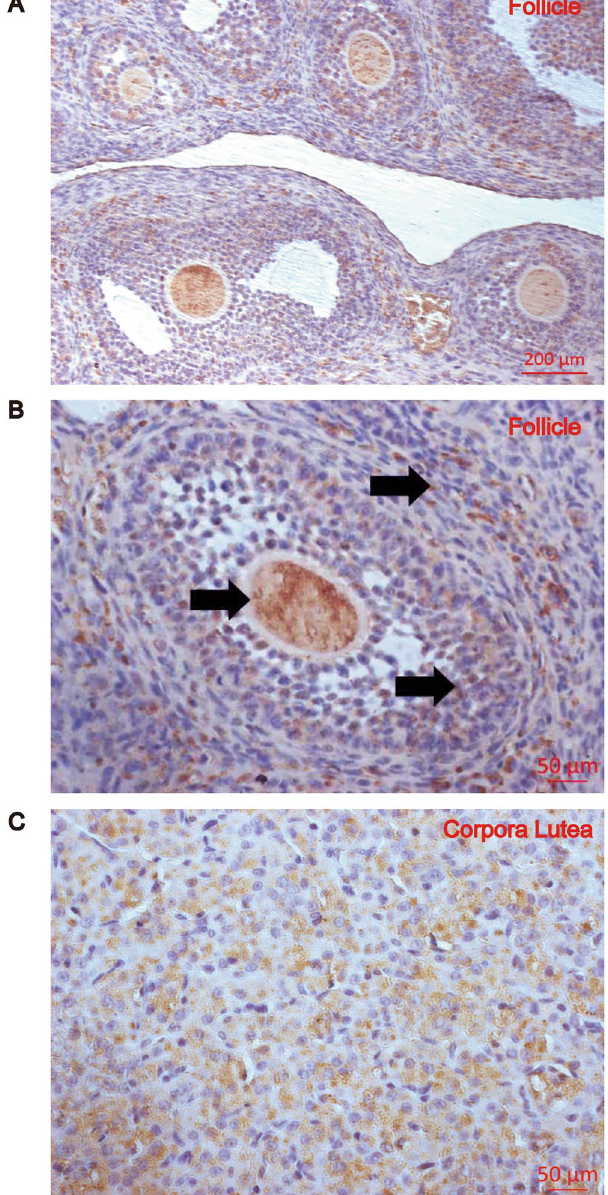
Figure 1. The distribution of ZNF217 in the ovaries of rats. ( A , B ) The location of ZNF217 in the follicles of control rats. Nuclei were counterstained with hematoxylin. ( C ) The expression of ZNF217 in the mature corpora lutea of control rats. Arrows showed the immunostaining of